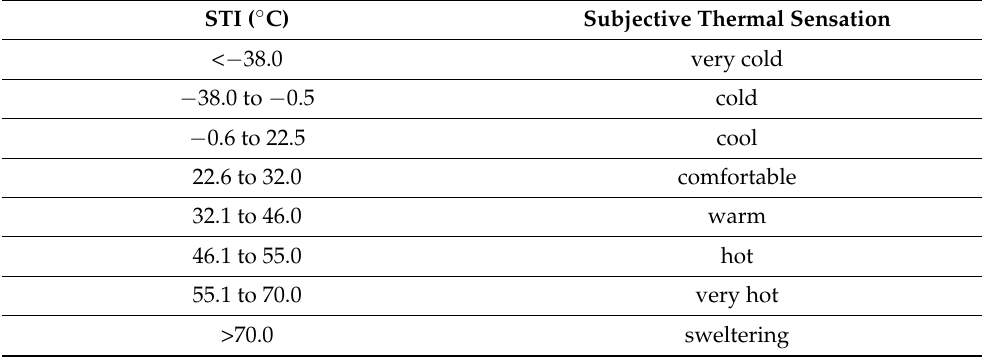
Table 2. Thermal Sensations based on the Subjective Temperature Index